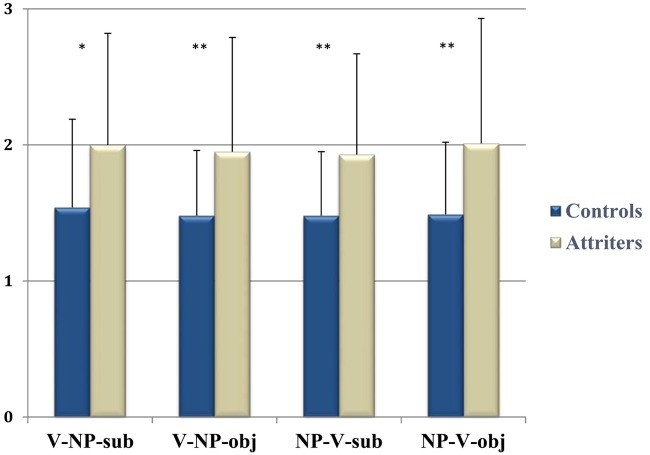
Group reaction times (in seconds) by condition. Attriters were consistently slower than Controls ∗p < 0.05, ∗∗p < 0.01. Error bars represent standard deviation.